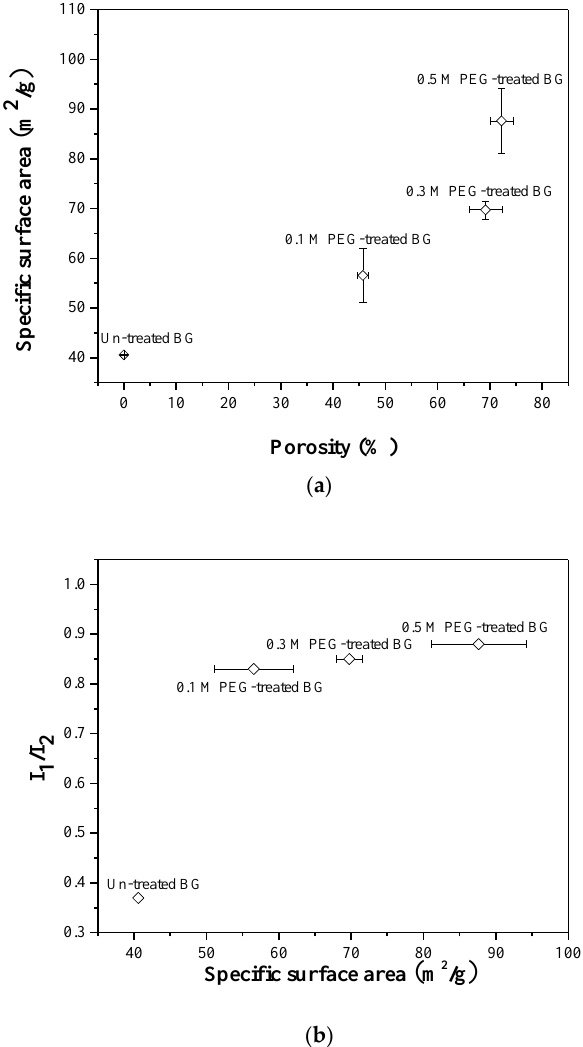
Materials 2019 , 12 , 3703 Figure 9. Correlations of ( a ) specific surface area to porosity and ( b ) bioactivity to a specific surface area.